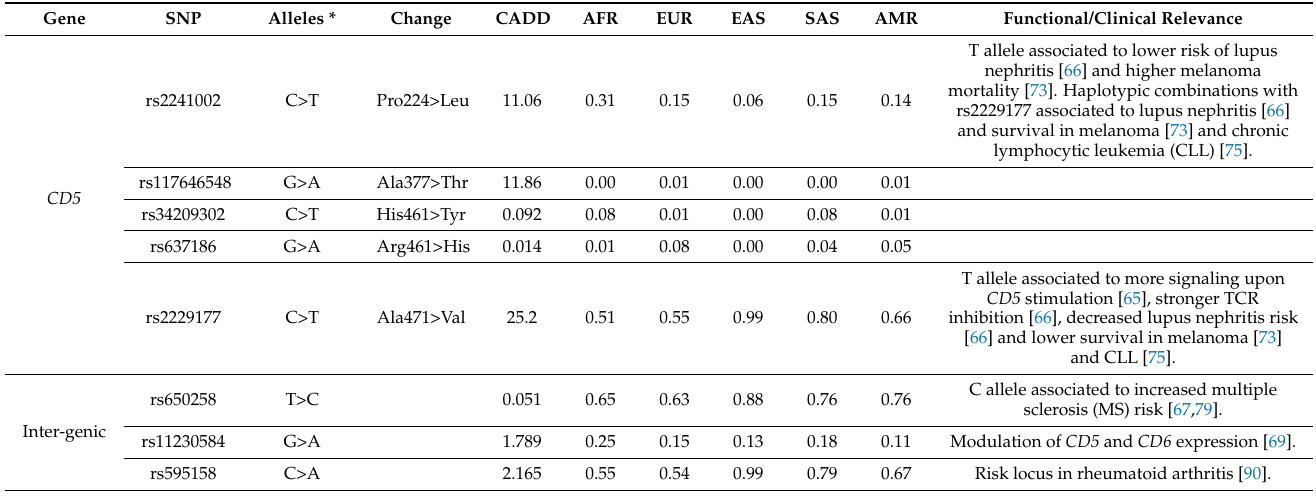
Table 1. Reported frequency of functionally and clinically relevant CD5 and CD6